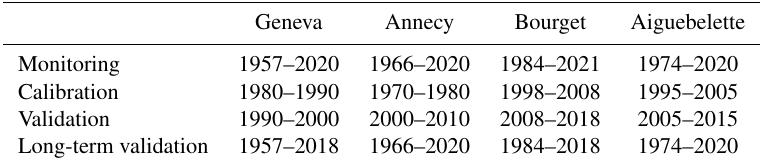
Table 2. Monitoring, calibration, and validation periods for the four peri-alpine lakes.